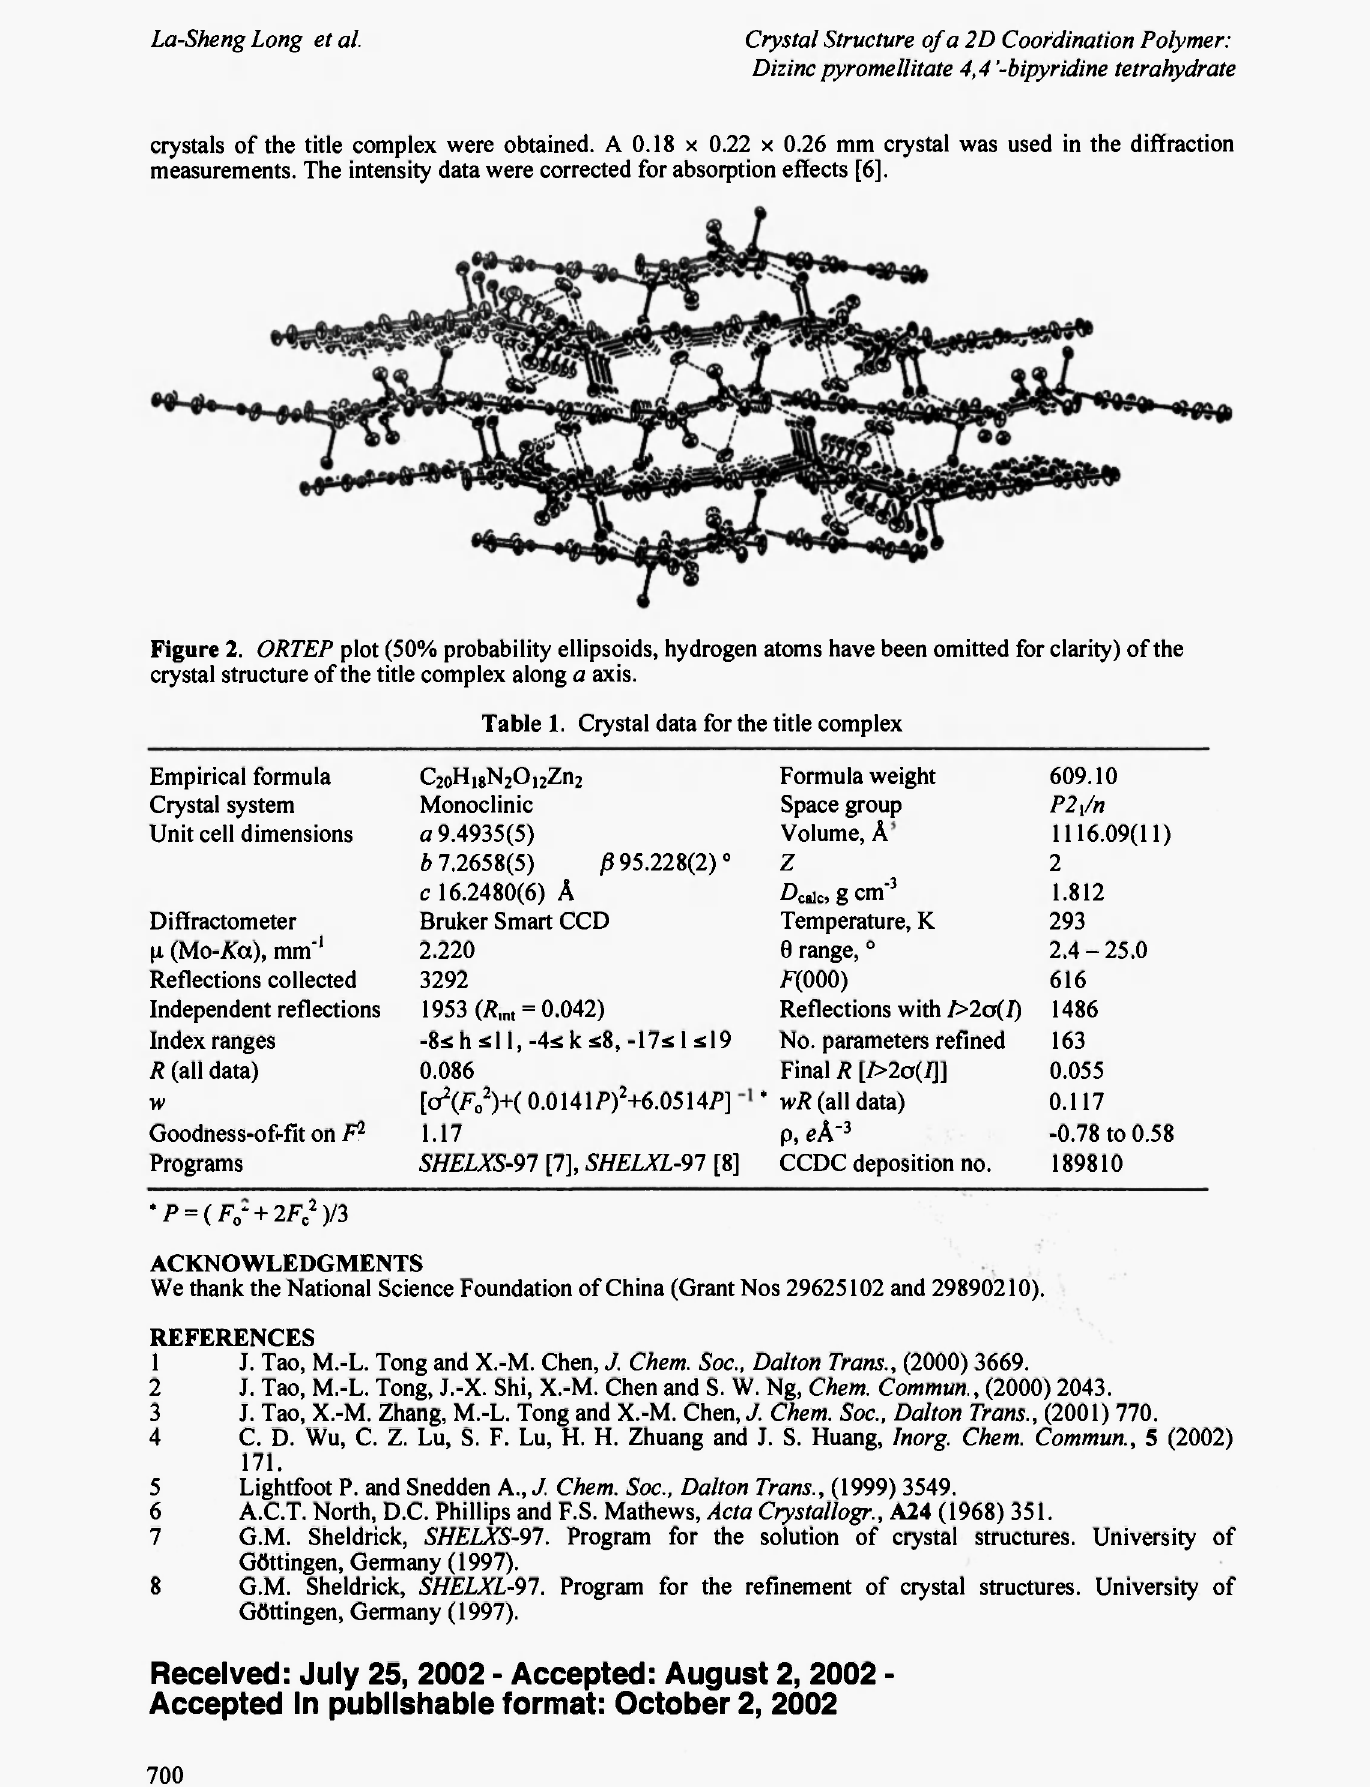
Figure 2. ORTEP plot (50% probability ellipsoids, hydrogen atoms have been omitted for clarity) of the crystal structure of the title complex along a axis. Table 1. Crystal data for the title